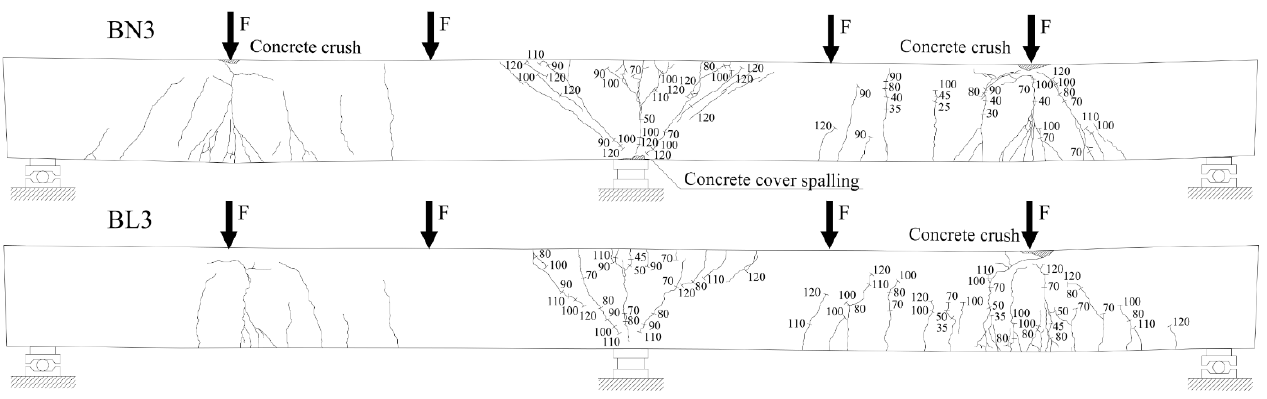
Figure 7. Crack propagation in BN2 and BL2 beams. Note: numerals given in figures indicate the applied load F (in kN). The drawings present the deformed beams after the removal of the load.